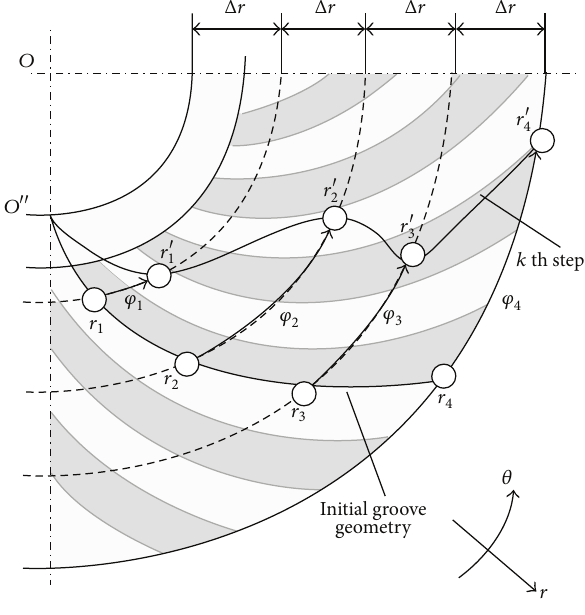
Figure 4: Modifications of groove